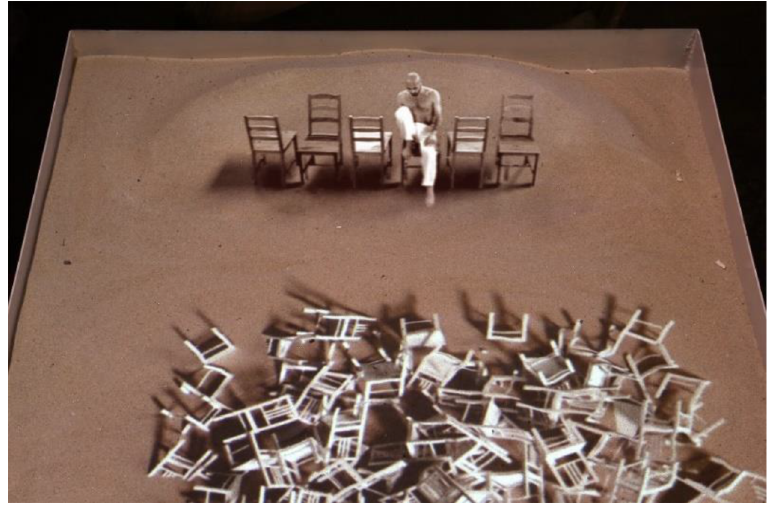
Figure 5. Ronen Sharabani, Sandbox (detail), 2014. Projection on sand table, 170 cm × 115